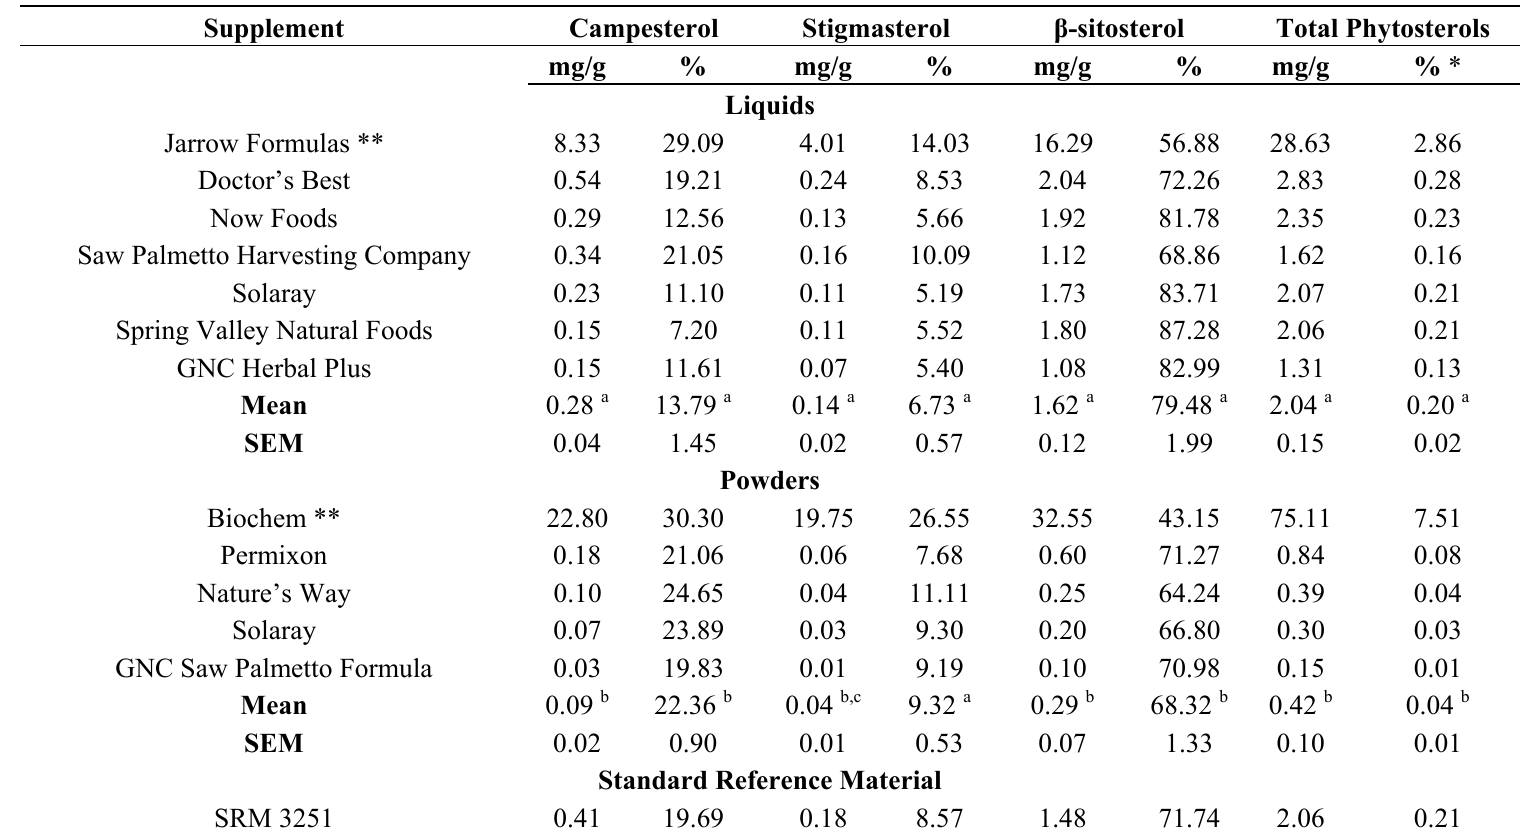
Table 4. Phytosterol quantities (mg/g) and composition (% of total phytosterols) in SRM, liquid and powder saw palmetto